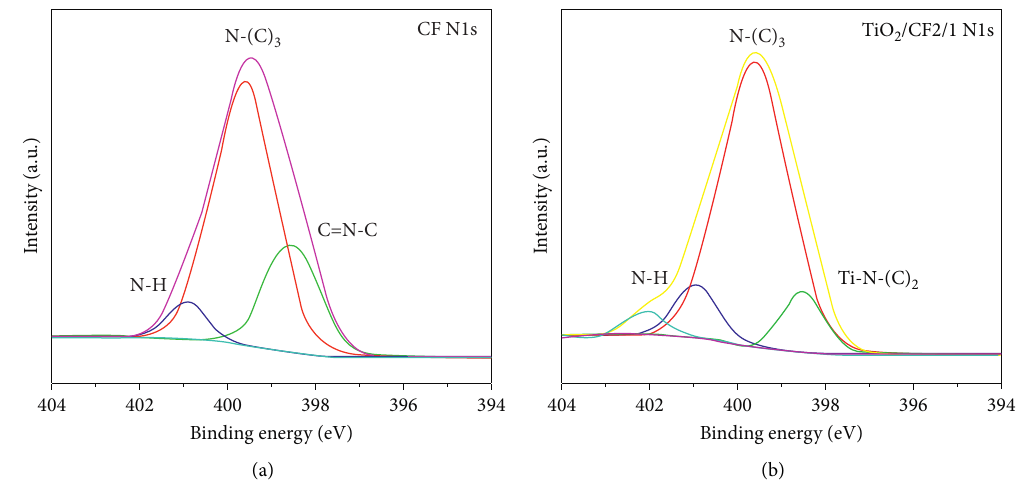
Figure 8: N 1s high-resolution XPS spectra of (a) CF and (b) TiO